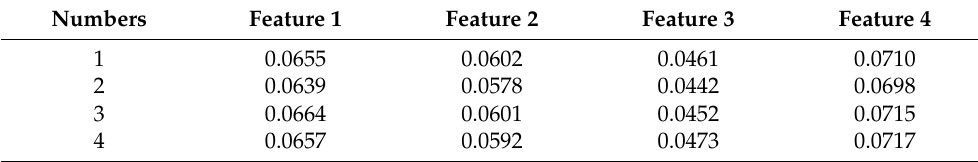
Table 2. CRPS values of the model with different Gaussian component